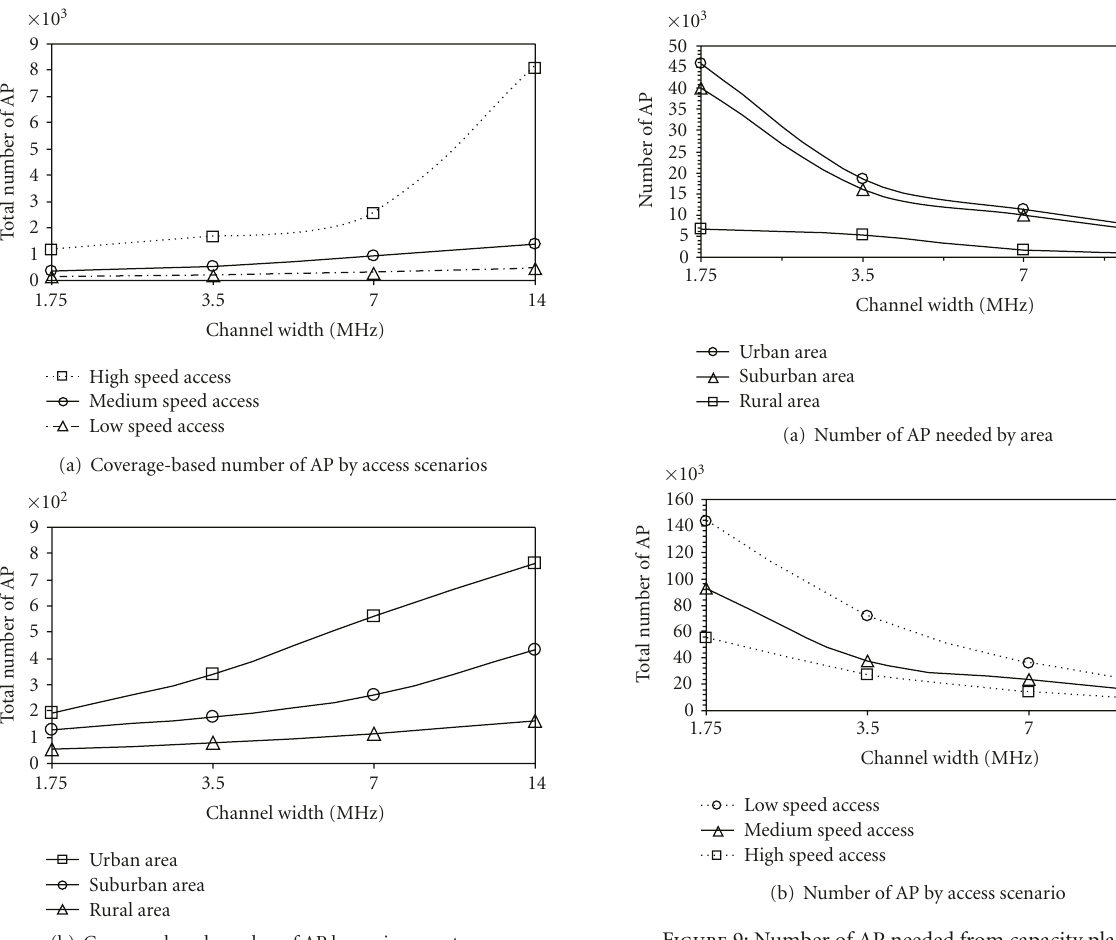
Figure 9: Number of AP needed from capacity planning.